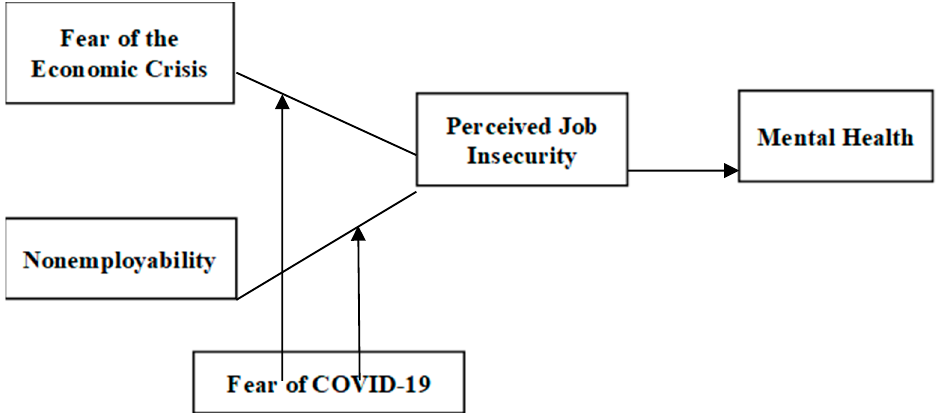
Figure 1. Research